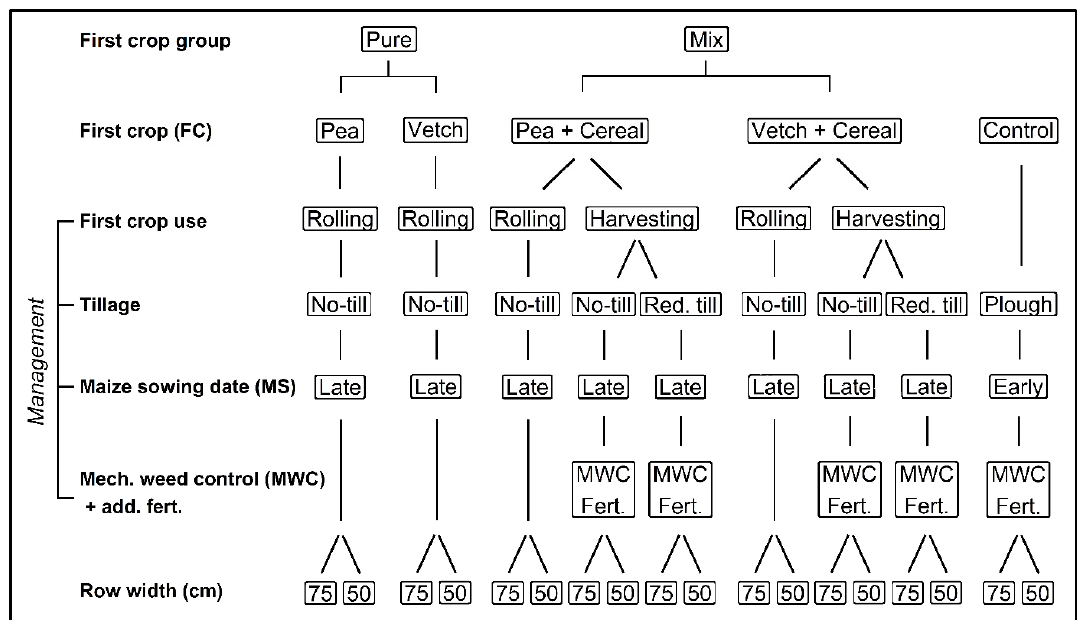
Figure 1. Treatment combinations common at both experimental locations. Abbreviations: red. = reduced, till = tillage, add. fert. = additional fertilization.